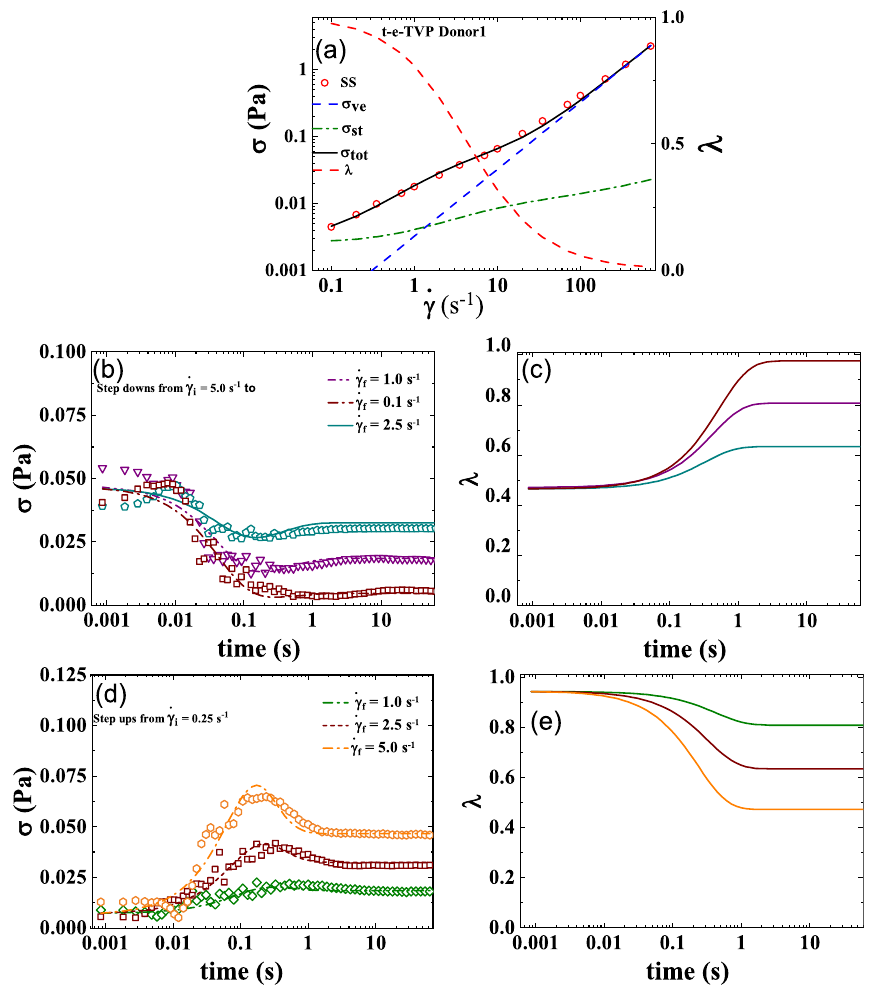
Figure 1. t-e-TVP fits to ( a ) steady state; ( b ) series of step downs from ˙ γ = 5 s −1 to 2.5, 1, 0.5 s −1 ; ( c ) representative structure parameter curves with colors corresponding to prior stress evolution curves; ( d ) step up in shear rate from ˙ γ = 0.25 s −1 to 1, 2.5, 5 s −1 ; and ( e ) representative structure parameter curves (Donor 1, Dataset 1) 49